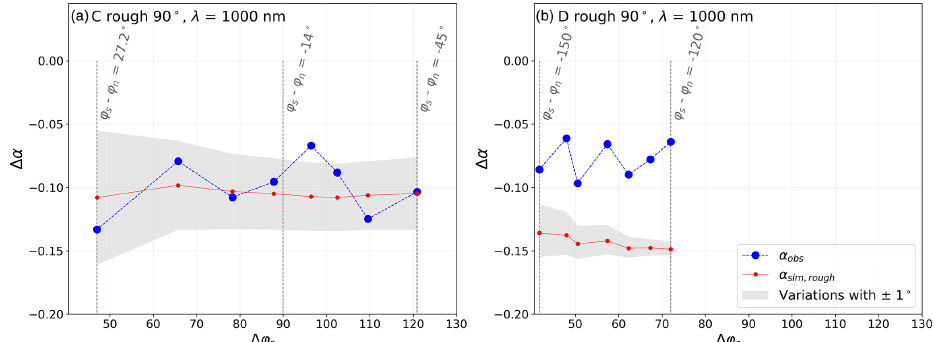
Figure 10. Same as Fig. 9c and d, except that the grey shading represents the range of (cid:49)α obtained by varying the slope by ± 1 ◦ in RSRT simulations for (a) experiment C rough 90 ◦ and (b) D rough 90 ◦ . ϕ n is the aspect of the slope and ϕ s is the solar azimuthal angle, separately given in Table 1. Vertical black lines indicate [ ϕ s – ϕ n ] angles at the beginning and at the end of experiments (and at (cid:49)ϕ r = 90 ◦ for experiment